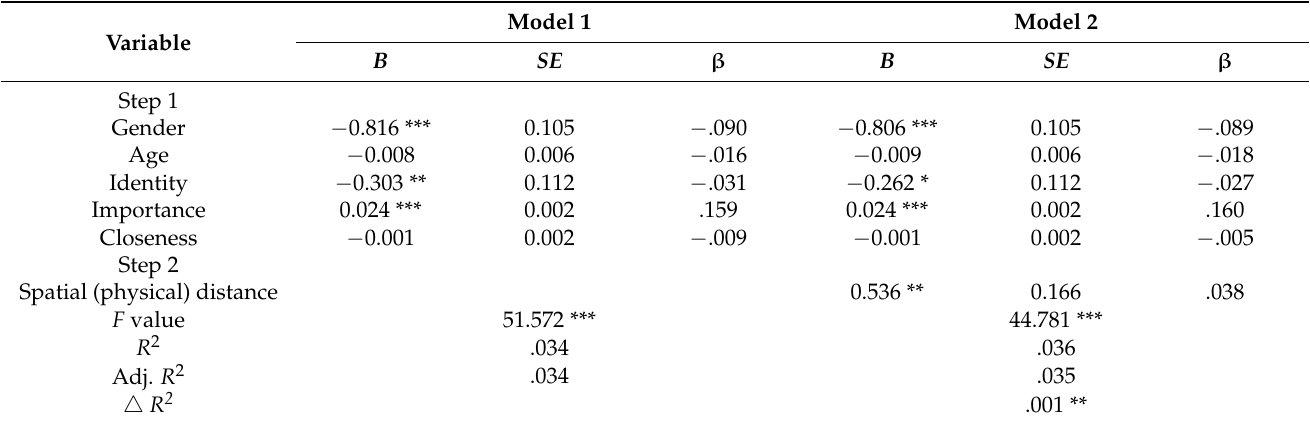
Table 5. Hierarchical OLS regression of demographic variables and spatial (physical) distance on the risk perception of COVID-19 in Wuhan ( N = 7283, adult data with no missing